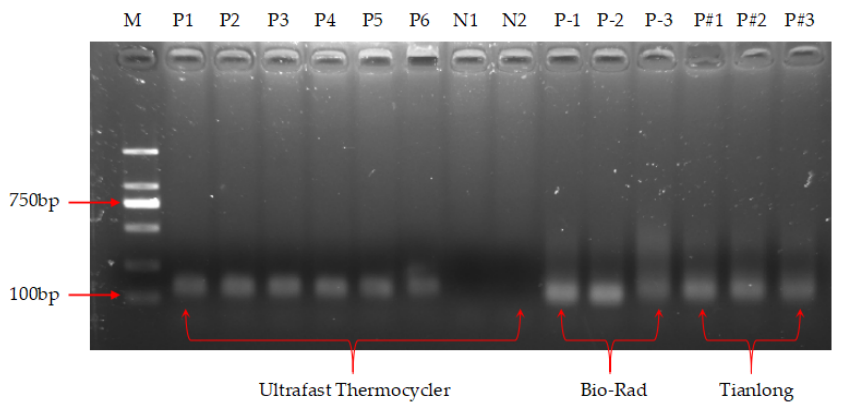
Figure 13. Agarose gel electrophoresis results of nucleic acid amplification. Lane M: DNA markers of different lengths; lanes P1, P2, P3, P4, P5, and P6: positive control of the thermocycler; lane N1 and N2: negative control of the thermocycler; lanes P–1, P–2, and P–3: products of the Bio-Rad instrument; lanes P#1, P#2, and P#3: products of the Tianlong instrument.